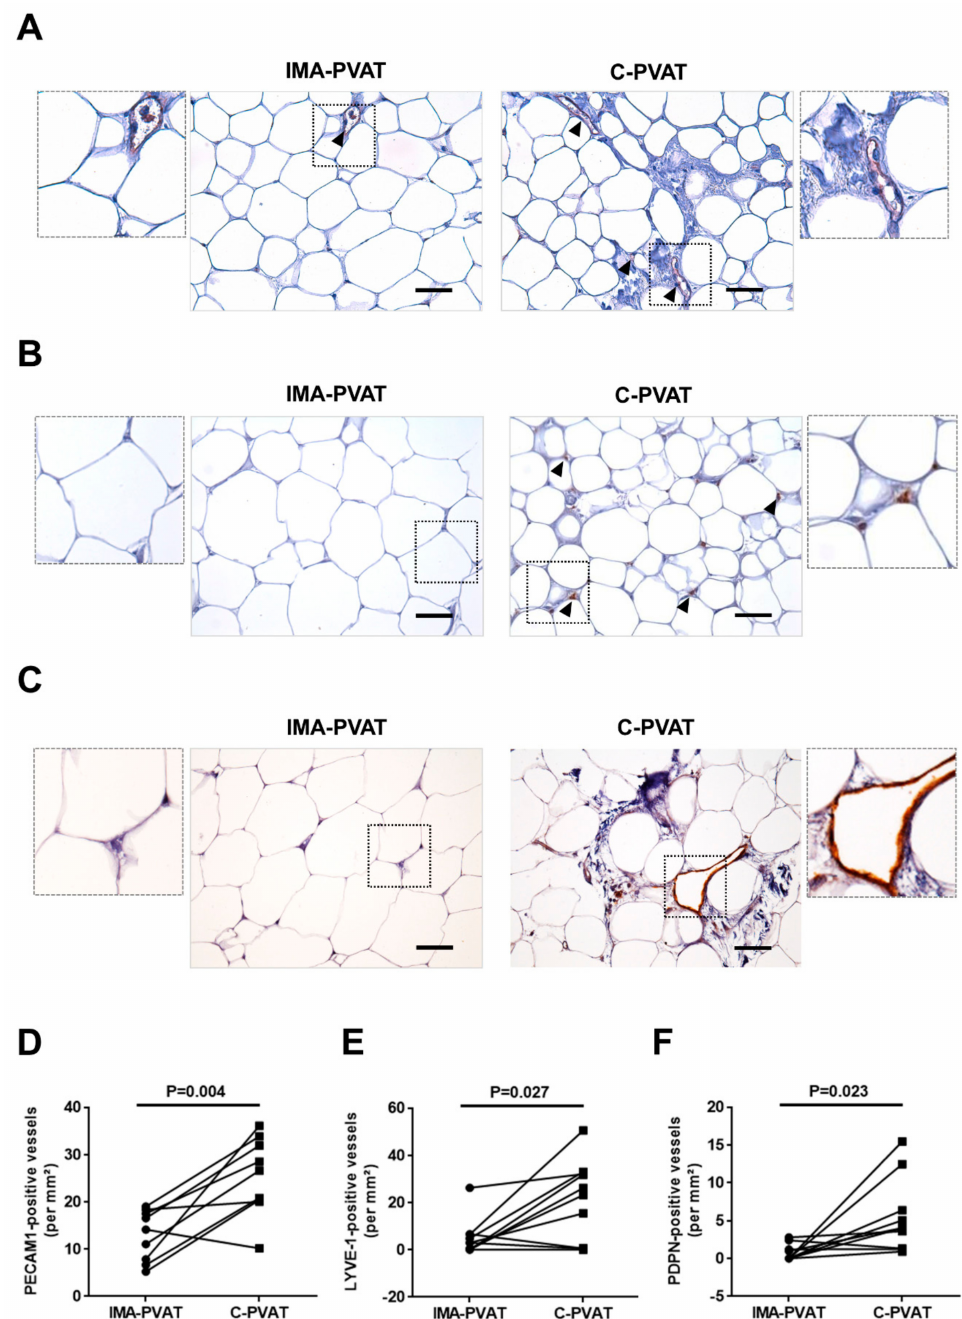
Figure 1. Angiogenesis and lymphangiogenesis in perivascular adipose tissue (PVAT). ( A–C ) Immunohistochemical detection of platelet endothelial cell adhesion molecule 1 (PECAM-1) ( A ), anti-lymphatic vessel endothelial hyaluronan receptor 1 (LYVE-1) ( B ), and anti-podoplanin (PDPN) ( C ) in internal mammary artery (IMA)-PVAT and cardiac (C)-PVAT. Inserts show higher magnification. Size bars represent 100 µ m. ( D – F ) Quantification of the number of PECAM-1 ( D ), LYVE-1 ( E ), and PDPN ( F ) immunopositive vessels per mm 2 in n = 10 patients with coronary artery disease (CAD). Paired IMA-PVAT ( (cid:8) ) and C-PVAT ( (cid:4) ) values in individual patients are connected with a line. Statistical analysis was performed using Student’s paired t -test ( D , F ) or Wilcoxon matched-pairs signed rank test ( E